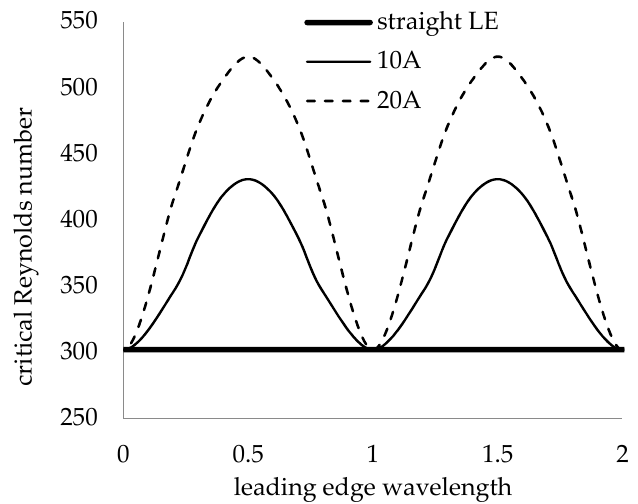
Figure 14. Critical Reynolds numbers for different leading-edge geometries.